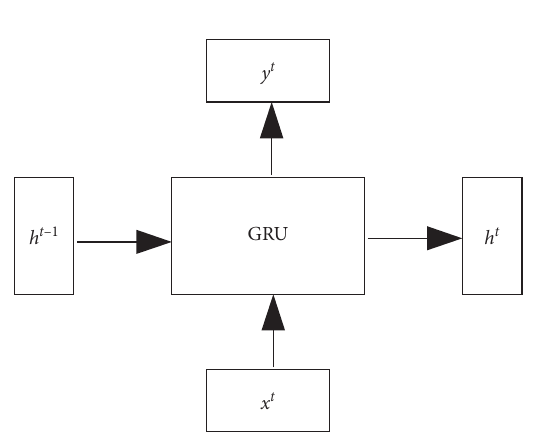
Figure 2: Input and output structure of GRU.